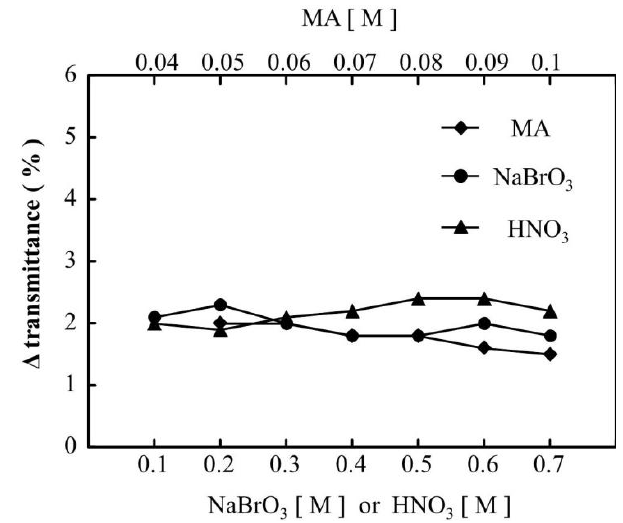
Figure 6. Dependence of the amplitude of the transmittance self-oscillation of the polymer solution at 14 °C for different Belousov-Zhabotinsky (BZ) substrate